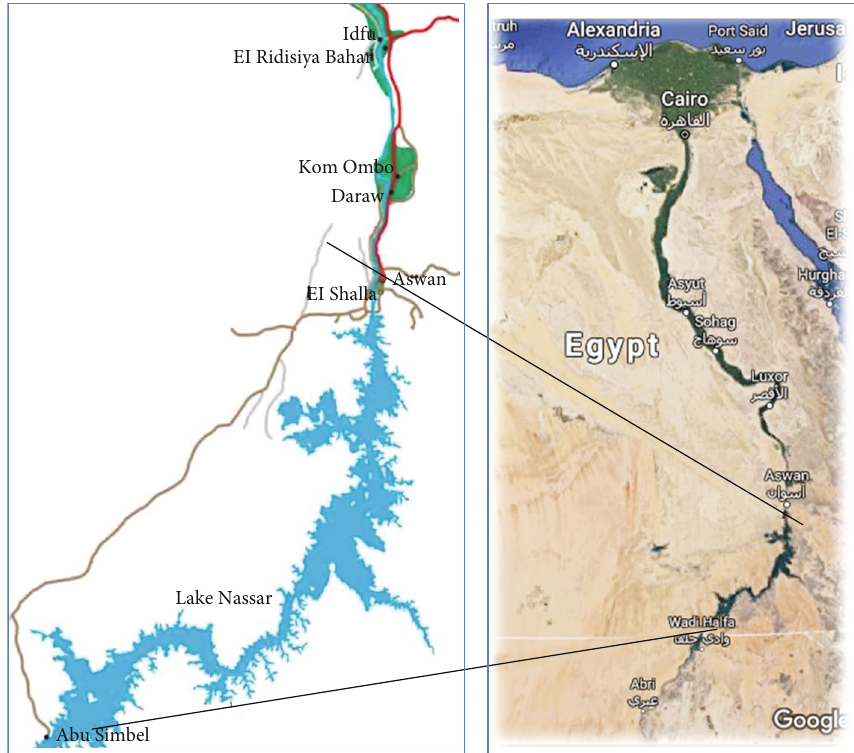
Figure 1: Location of Lake Nasser in Egypt